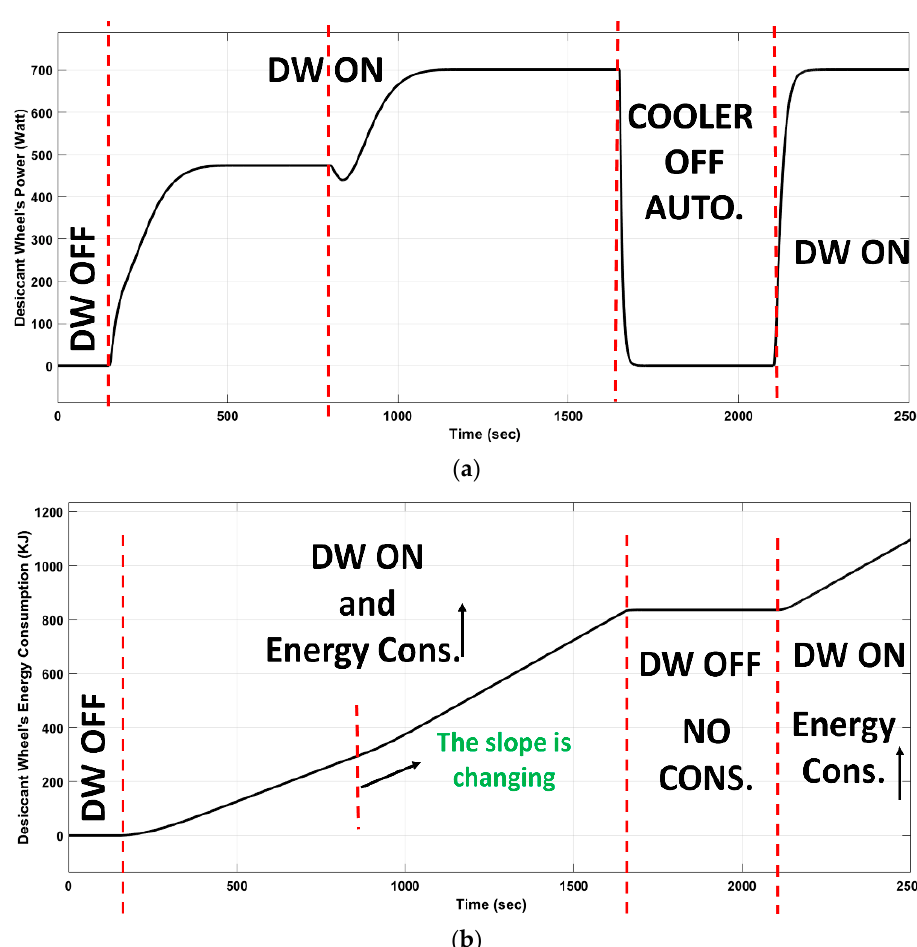
Figure 6. ( a ) The power consumption of the desiccant wheel. ( b ) The energy consumption of the desiccant wheel.